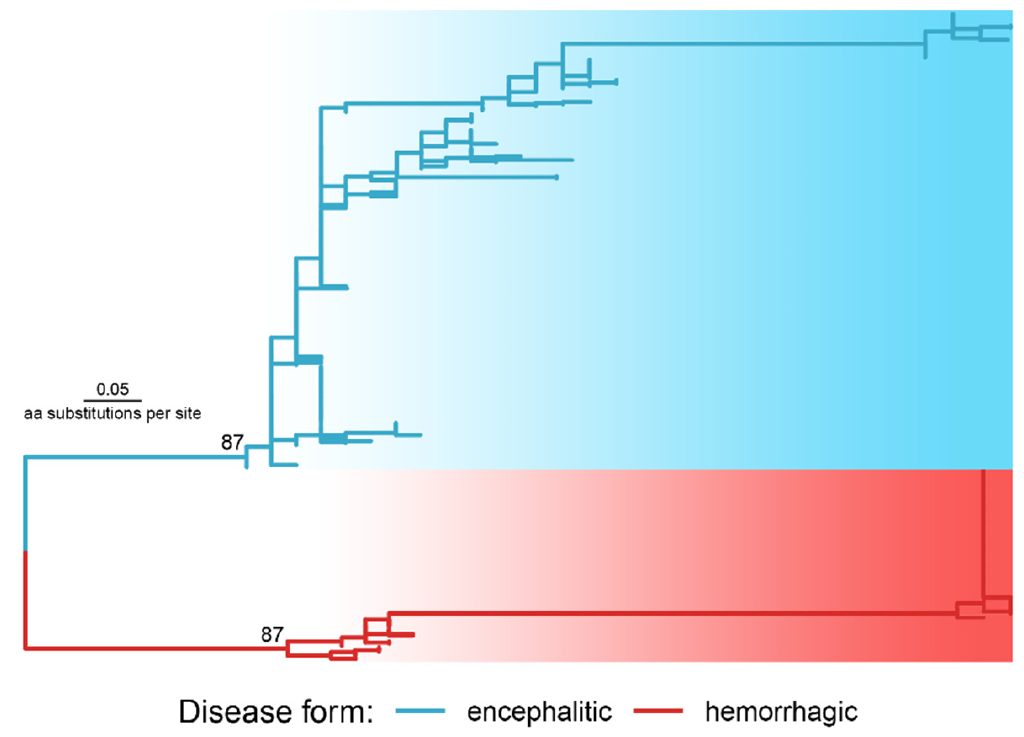
Figure 3. The phylogenetic tree reconstructed with the polyprotein regions selected as molecular determinants of disease forms (a newick tree file is available at https://doi.org/10.6084/m9.figshare.21154495, accessed on 1 October 2022). The tree was rooted in a midpoint of the two longest tips. The numbers at the nodes are ultrafast bootstrap values.